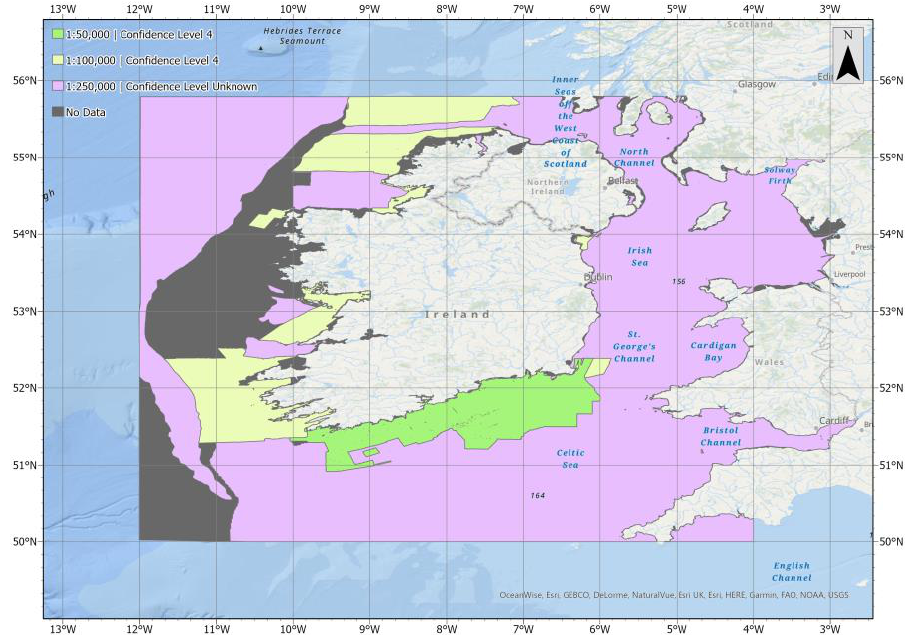
Figure 3. The geospatial availability of each seabed substrate dataset and areas with no data coverage.